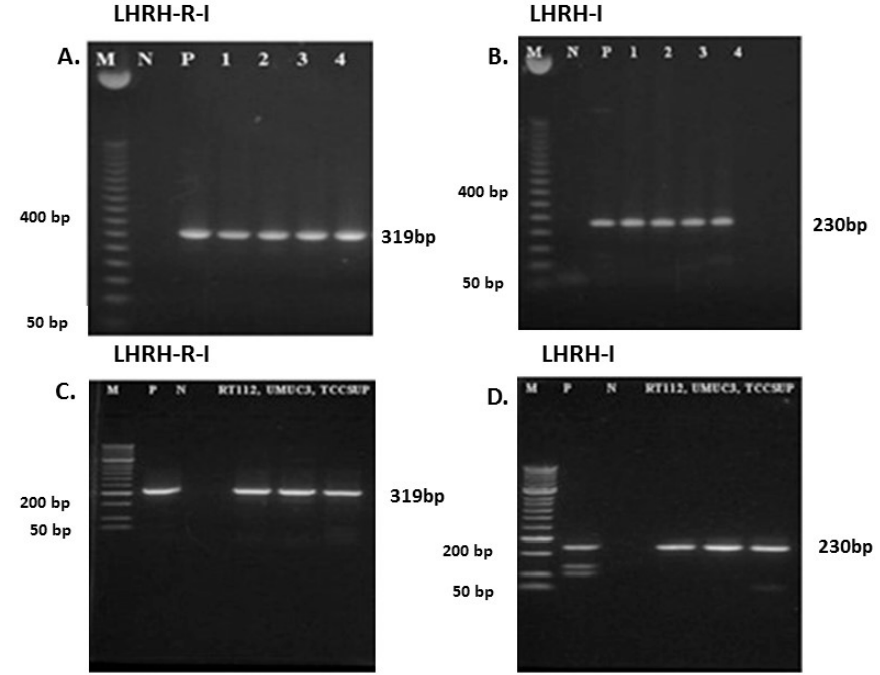
Figure 1. Representative RT-PCR analysis of mRNA for LHRH-I and LHRH-R-I in human bladder tumor specimens and three bladder cancer cell lines. ( A,C ) The PCR products were of the expected size of 319 bp for LHRH-R-I; ( B,D ) The PCR products were of the expected size of 230 bp for LHRH-I). Lane M, molecular marker (50-bp DNA ladder); Lane P, positive control (human pituitary tissue); Lane N, no template control; Lanes 1–4 ( A , B ) representative human bladder cancer specimens; Panels ( C , D ) representative human bladder cancer cell lines (RT-112, UMUC3, and TCCSUP).